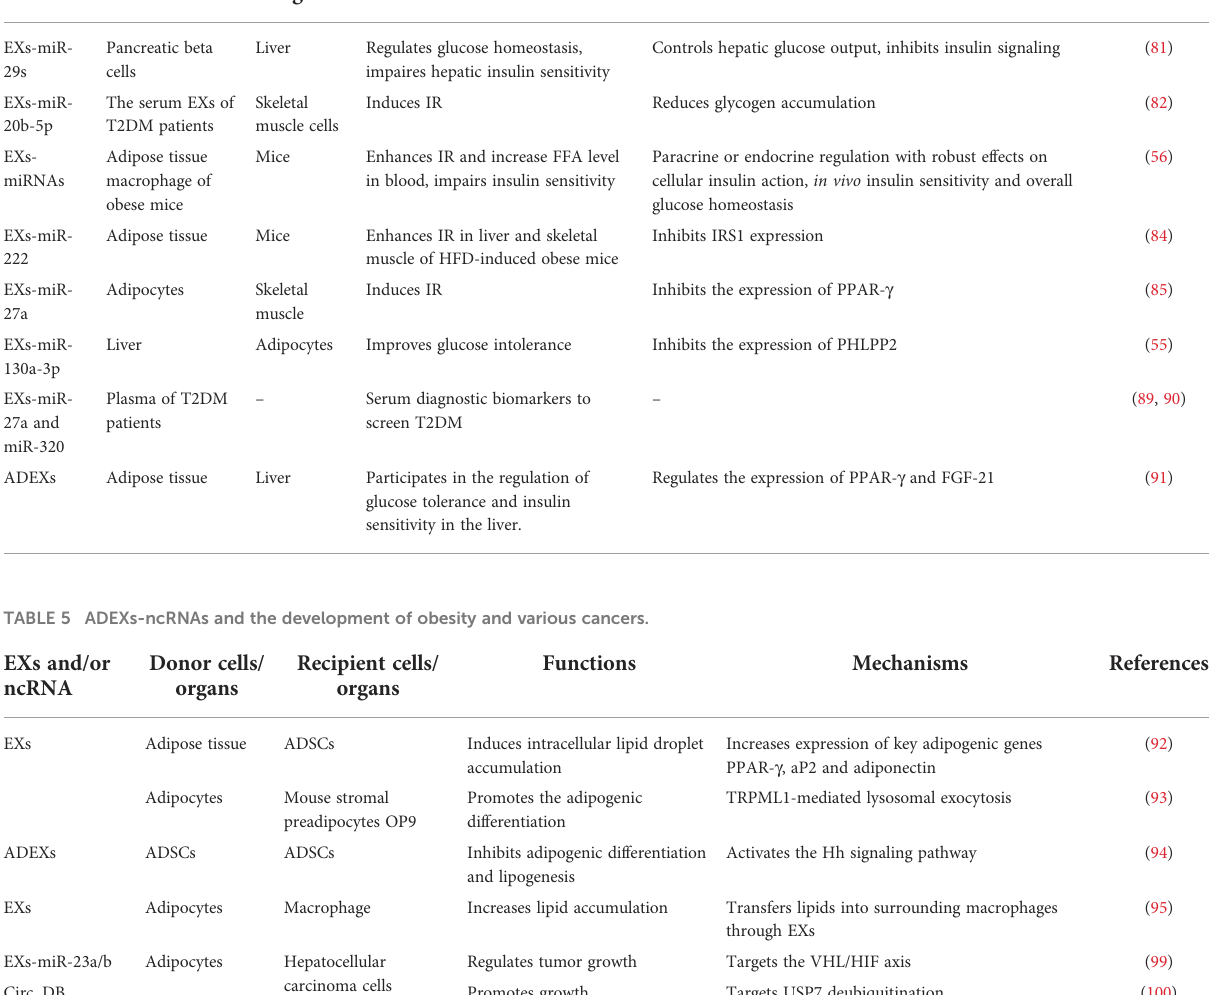
TABLE 4 Adipose tissue-derived EXs and/or ncRNAs and IR. EXs and/ or